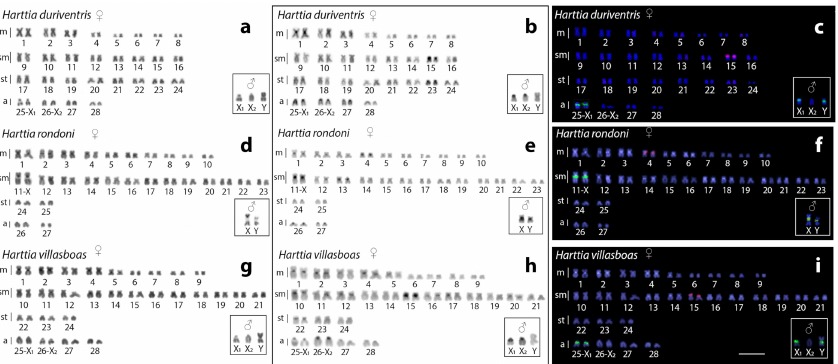
Figure 2. Karyotypes of H. duriventris ( a–c ) H. villasboas ( d–f ) and H. rondoni ( g–i ) arranged by sequentially Giemsa-stained ( a , d , g ) and C-banded chromosomes ( b , e , h ) and hybridized with 5S rDNA (red) and 18S rDNA (green) probes after a double-FISH analysis ( c , f , i ). Boxes depict the male sex chromosomes. Bar = 5 µ